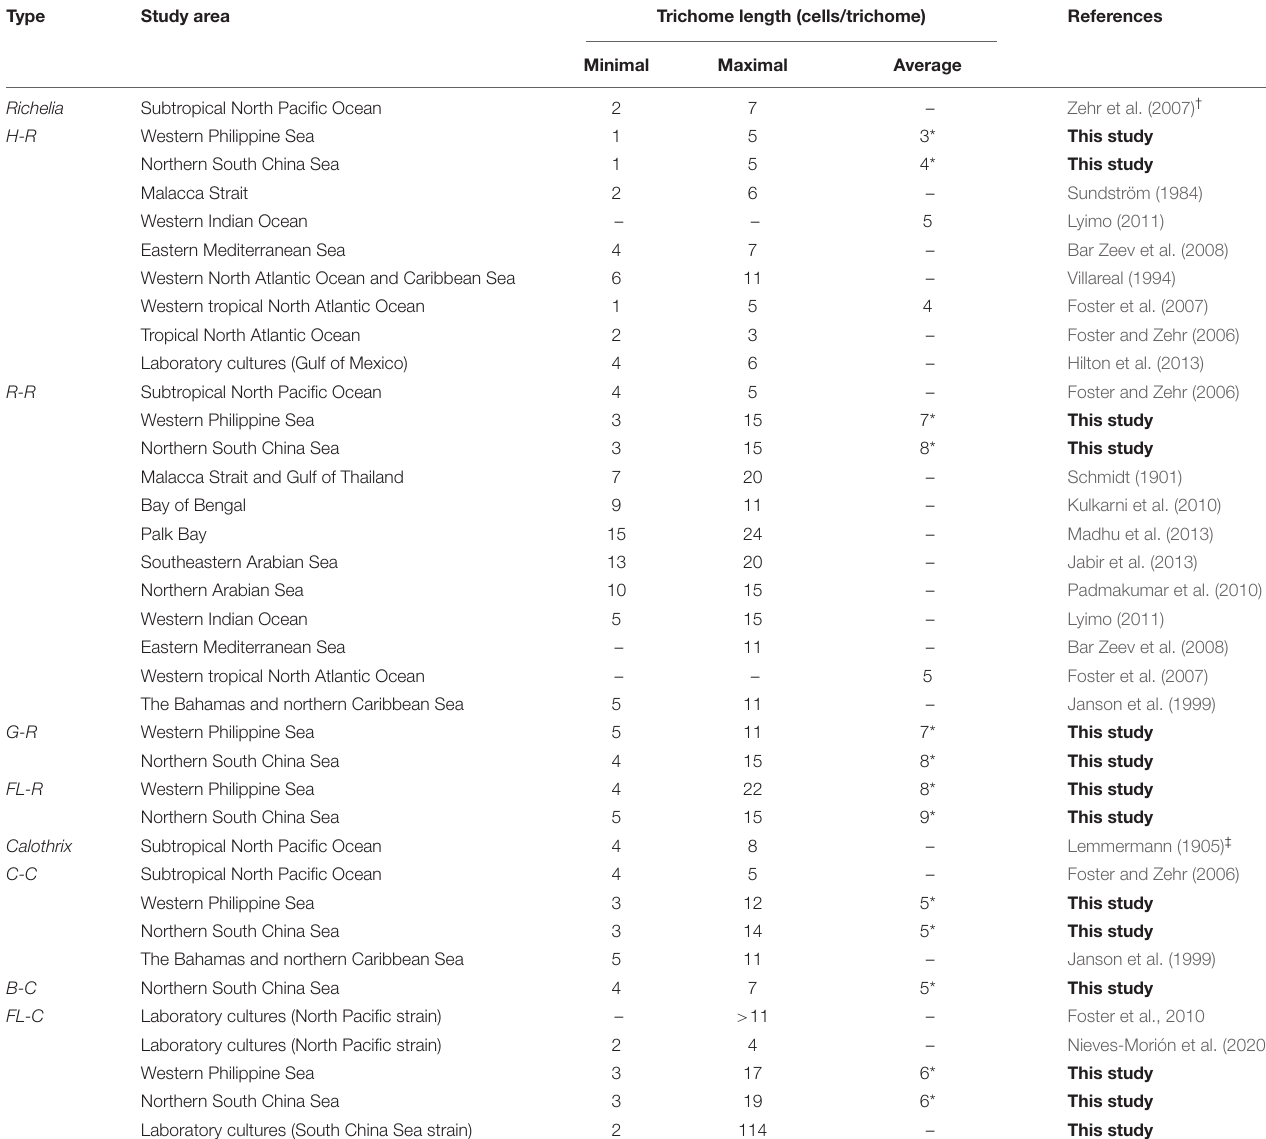
TABLE 4 | Trichome lengths of Calothrix and Richelia symbionts by